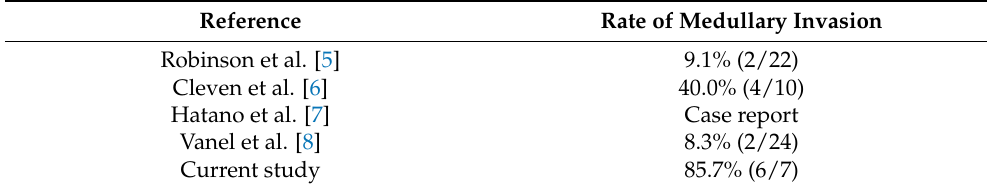
Table 3. Comparison of previous studies of periosteal chondrosarcoma with invasion of the medullary